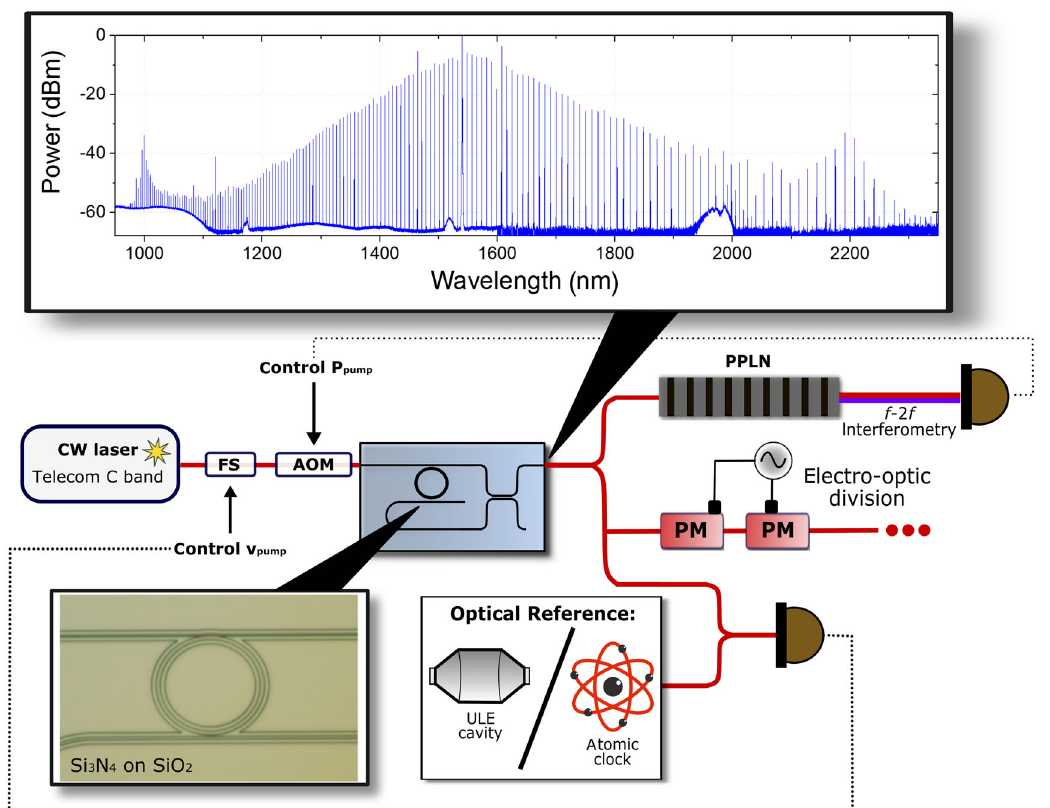
FIG. 1. Schematic of the Kerr-microresonator clockwork. The microresonator is a Si 3 N 4 ring with radius of 23 μ m. It is pumped with a CW laser that is coupled into a 720-nm-wide access waveguide (upper waveguide in this picture) via lensed fibers. The resultant comb spans more than an octave, and wavelengths from 900 to 1900 nm are outcoupled from the resonator via the access waveguide through port, while wavelengths greater than 1900 nm are outcoupled via a drop port to a 1200-nm-wide waveguide (lower waveguide in this picture). The comb light is recombined via an adiabatic dichroic coupler before leaving the chip. The microcomb is stabilized through f - 2 f interferometry and locking to an optical-frequency reference. The f - 2 f technique is carried out with a waveguide PPLN (periodically poled lithium niobite) and a PID (proportional-integral-derivative) feedback circuit controlling the CW pump intensity via an acousto-optic modulator (AOM). The optical reference (a ULE-cavity-stabilized laser in this paper) creates a heterodyne beat with one of the comb modes, and a second PID feedback circuit controls the CW pump frequency via a QPSK modulator (FS). When both PID feedback circuits are operational, the fractional stability of the optical cavity is transferred to f , using OFD. The full comb rep spectrum is also sent through a series of electro-optic phase modulators (PM) to reduce the effective repetition